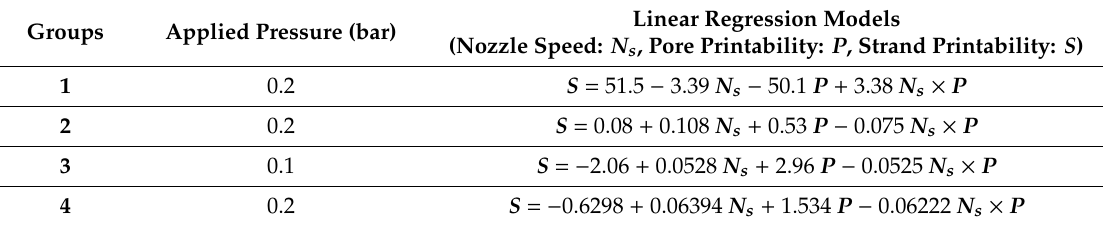
Linear Regression